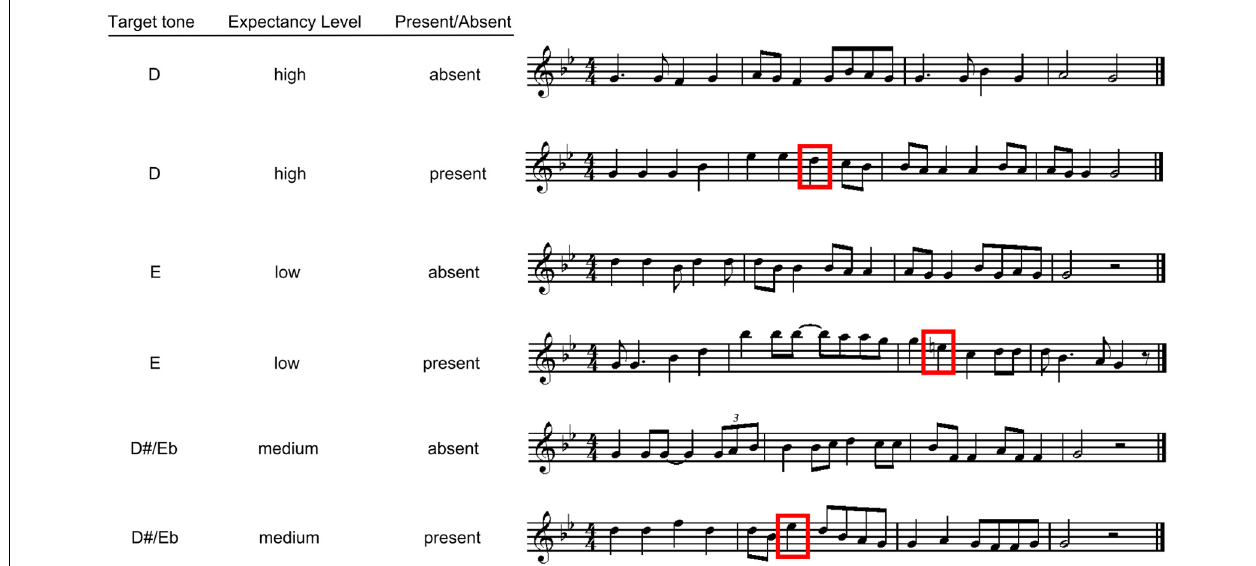
FIGURE 3 | Examples of experimental stimuli for Experiment 2. The boxes indicate present targets.